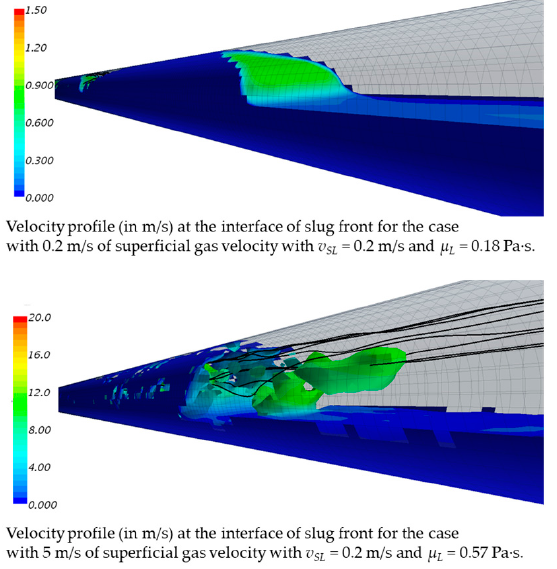
Figure 4. Simulated three-dimensional velocity profiles (in m / s) at the interface [33].